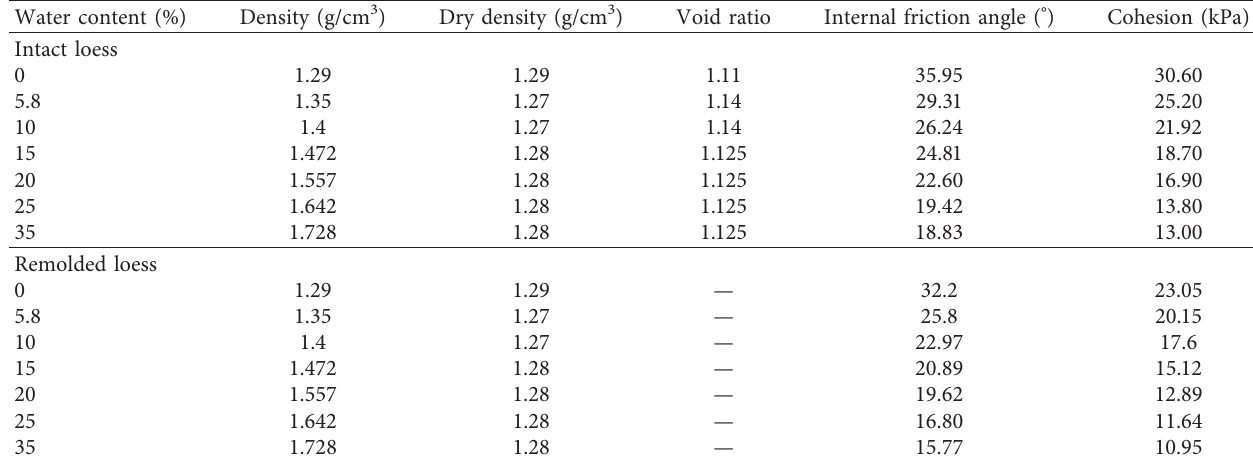
Figure 4: The photos of (a) the experimental process of direct shear test and (b) intact loess, remolded loess, sandy silt, sandy silt mixed with quartz flour, and quartz flour. Table 2: Properties and direct shear test results of the